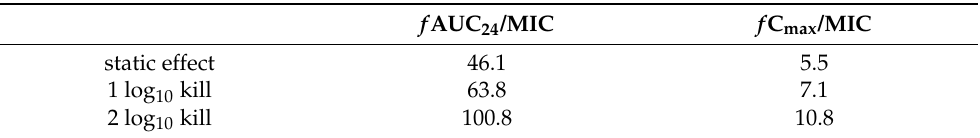
Table 3. Target values of pazufloxacin f AUC 24 /MIC and f C max /MIC for a static effect and 1, and 2 log 10 kill against P . aeruginosa in the thigh infection